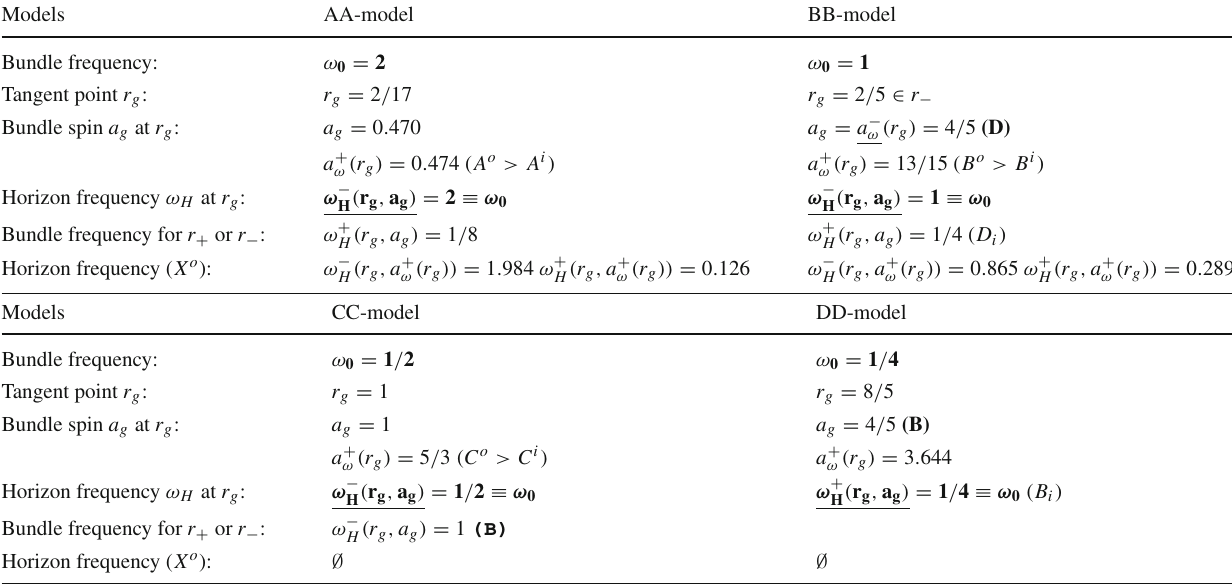
Table 3 Models XX , where X = { A , B , C , D } as defined in Fig.